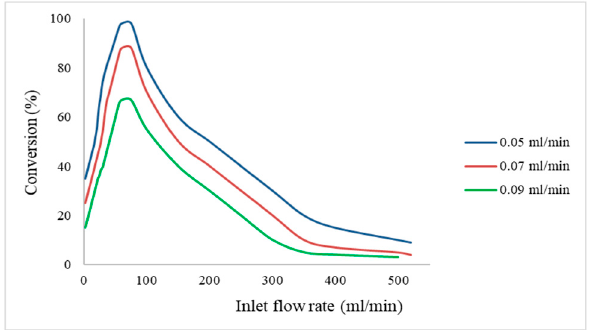
Figure 7. Effect of inlet liquid flow on the conversion of formic acid. Reaction conditions: temperature = 30 °C; pressure = 1 bar; 0.1 g catalyst of 5 wt.% Pd on carbon.